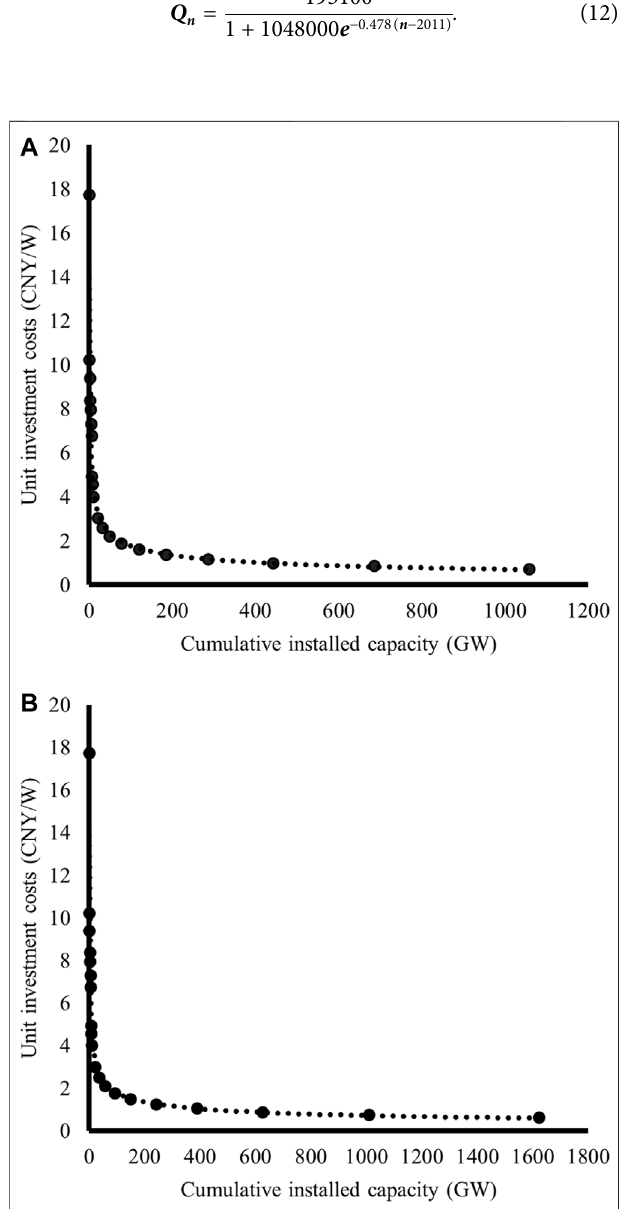
FIGURE 5 | Learning curve function of the cumulative installed capacity (GW) and unit investment costs (CNY/W) of centralized PV projects in Ningxia Province from 2011 to 2030 under the general forecast (A) and optimistic forecast (B)